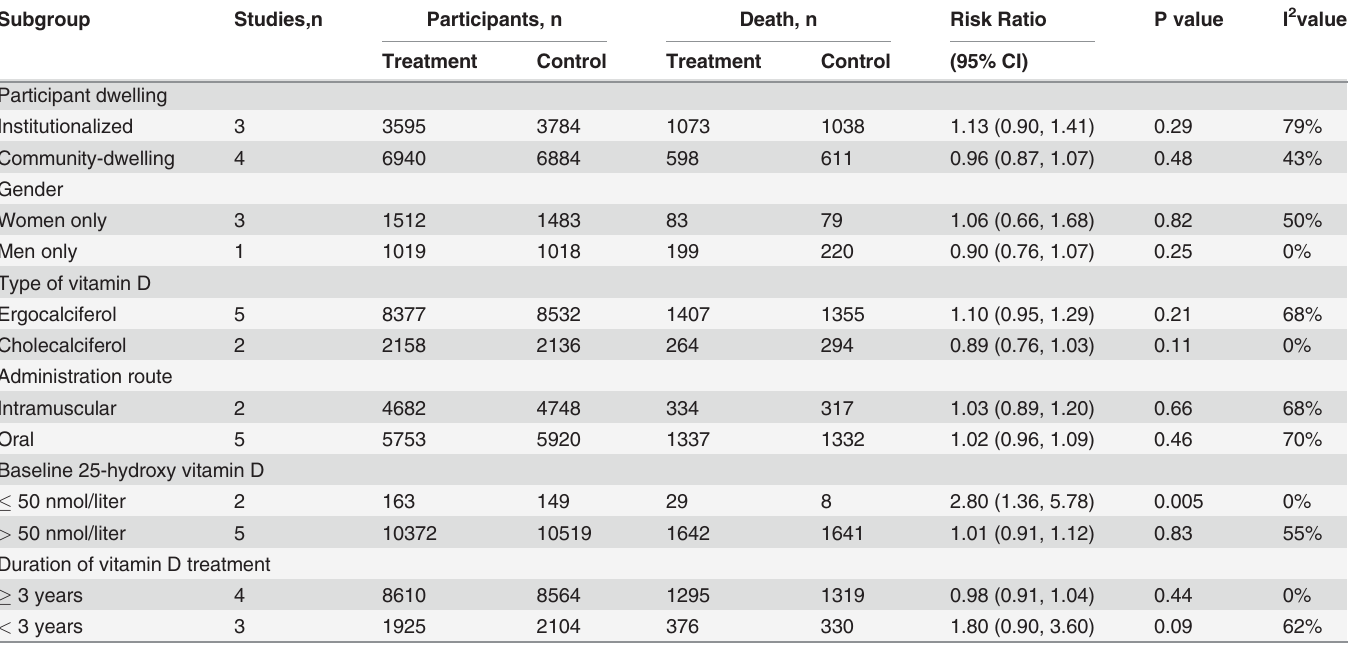
Table 3. Subgroup analyses of high-dose, intermittent vitamin D treatment on